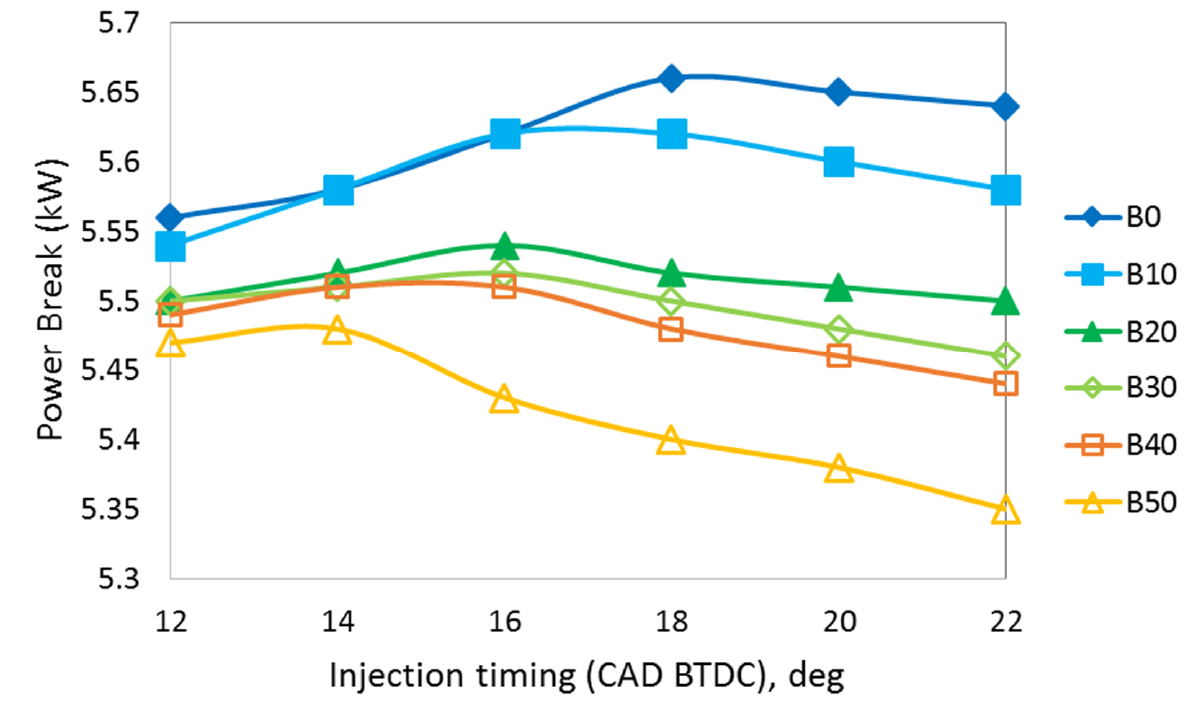
Figure 14. Effect of injection timing on engine power.